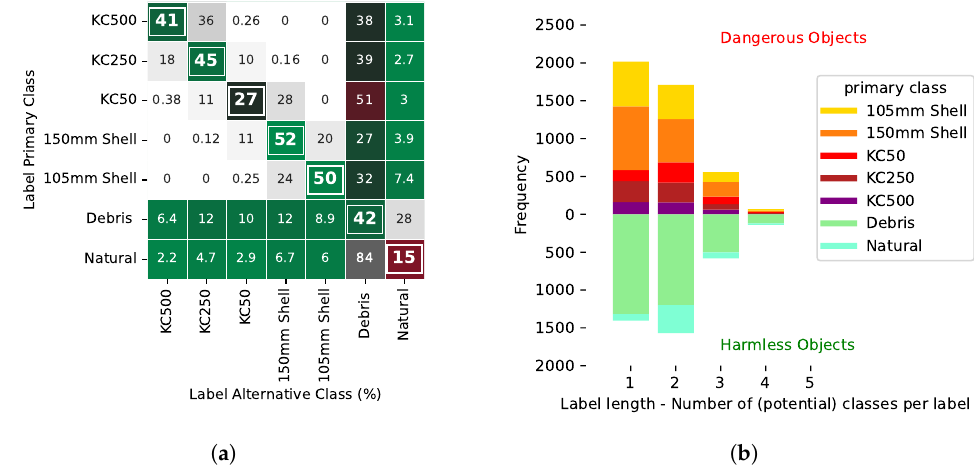
Figure 5. ( a ) Confusion matrix: Percentage of labels with primary class (Y-axis) that also contain (alternative) class (X-axis). Along the diagonal is the percentage of labels that contain only one class. ( b ) Distribution of unexploded ordnance (UXO) classes across different label lengths (uncertainty